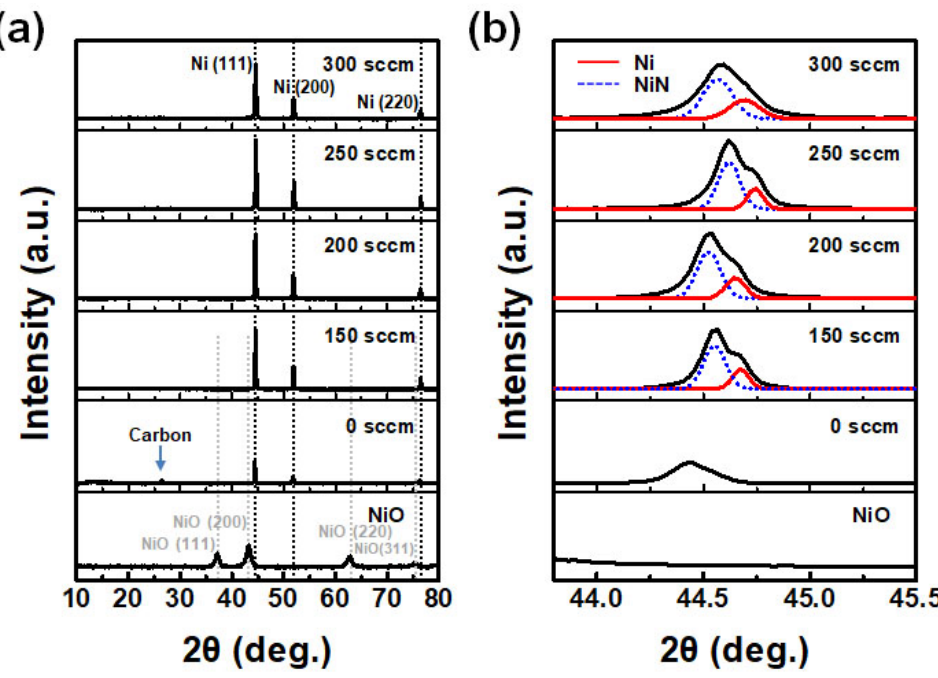
Figure 1. ( a ) XRD patterns of the nitrogen-doped Ni-graphene CSNPs synthesized at different NH3 flow amounts and ( b ) magnification and peak separation of Ni (111) peak positions in Figure 1a.